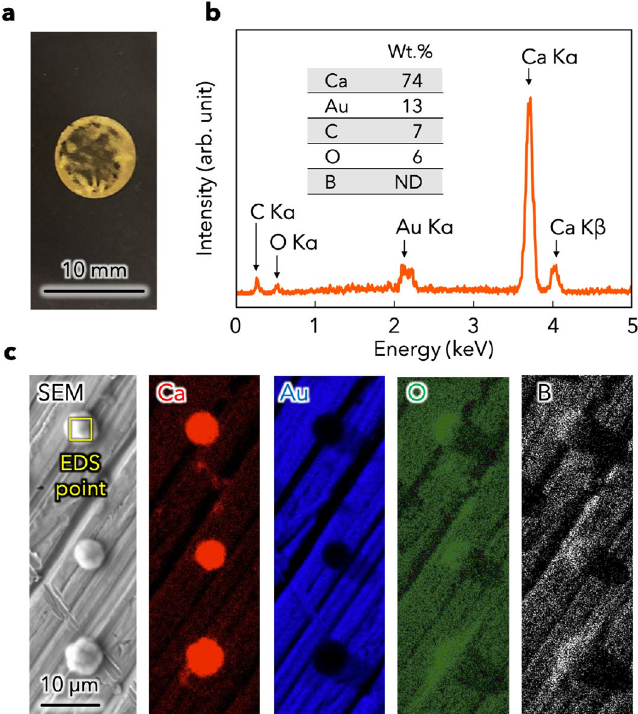
Figure 3. ( a ) Optical image of the Au electrode after a Ca plating process. ( b ) Energy-dispersive X-ray spectroscopy (EDS) profile within the yellow square. ( c ) Scanning electron microscopy (SEM) image of Ca deposits on the Au electrode after Ca plating in a Au | CMC/DME/THF | Ca cell, and EDS maps of Ca, Au, O, and B.